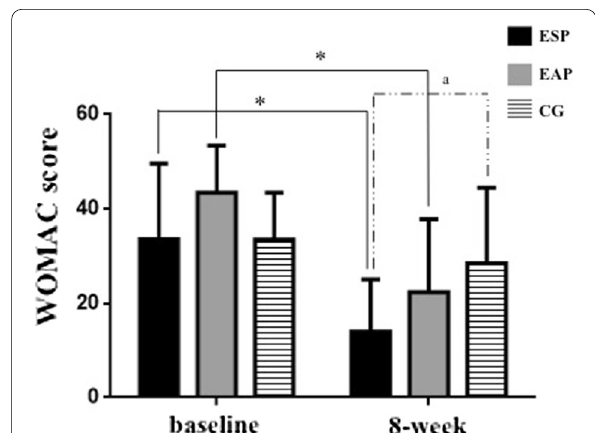
Fig. 2 Values of WOMAC in the baseline and in the 8-week for all the experimental groups. WOMAC: Western Ontario and McMaster Universities Osteoarthritis Index; ESP: exercise and sham PBM group; EAP: exercise and active PBM group; CG: control group. * statistical significance between in the baseline and in the 8-week. a Statistical significance from ESP group in the same